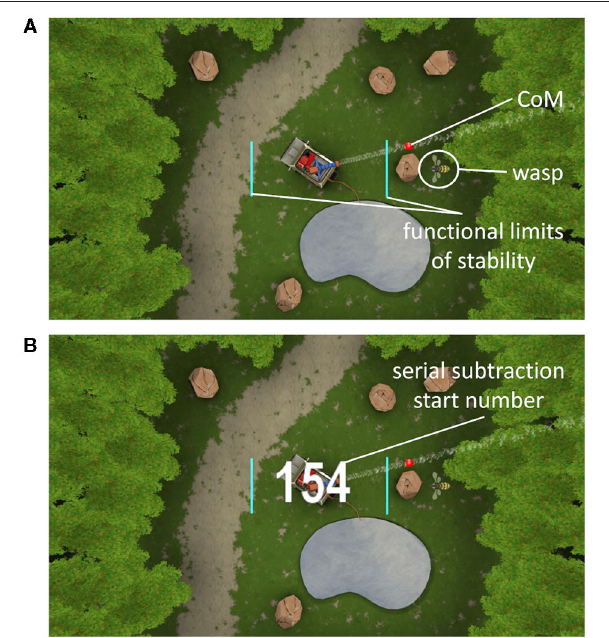
FIGURE 1 | Weight-shifting wasp game (A) . The turquoise lines indicate 80% of the individual’s lateral limits of stability. The red dot displays the center of mass (CoM). By moving the CoM laterally beyond the turquoise lines, the water jet was activated to hit the wasps that appeared on the left or right side of the screen alternately. Start screen of the serial subtraction single- and dual-task (B) . The white number represents the starting number, which was visible during the first 1.5s